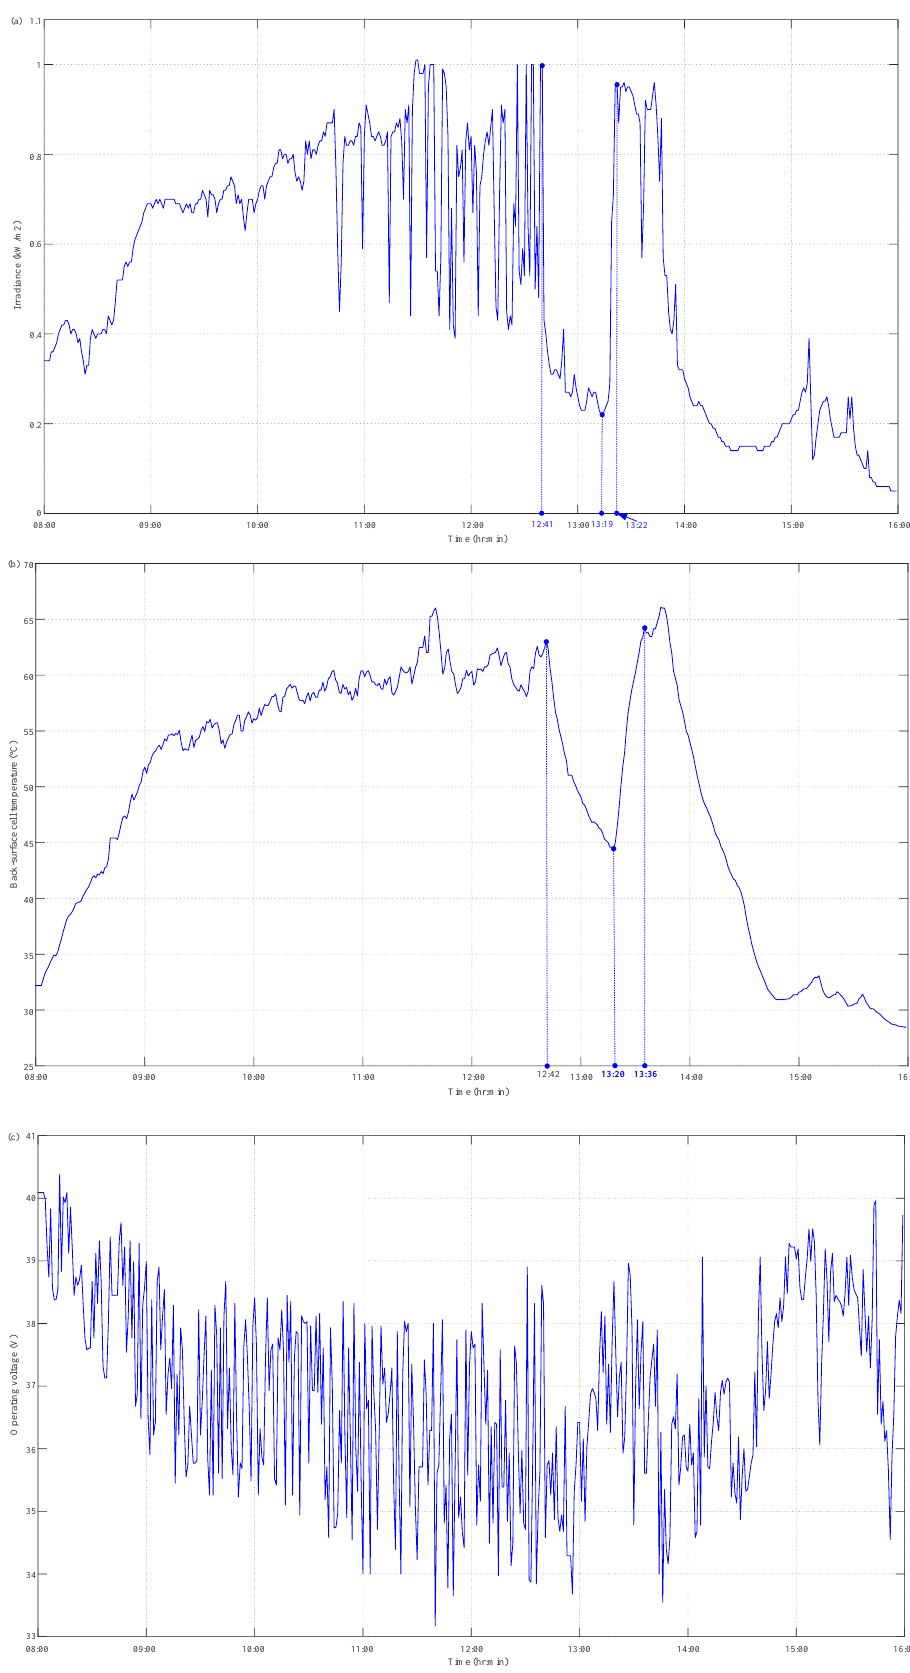
Figure 6. Measured results of PVEFD system: ( a ) irradiance; ( b ) cell temperature; ( c ) voltage.